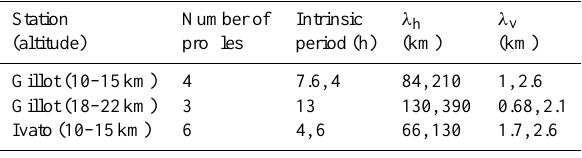
Table 1. Spectral characteristics of GWs above radiosonde stations of Gillot and Ivato from 15 to 18 February 2008 ( λ h and λ v : hori- zontal and vertical wavelengths).